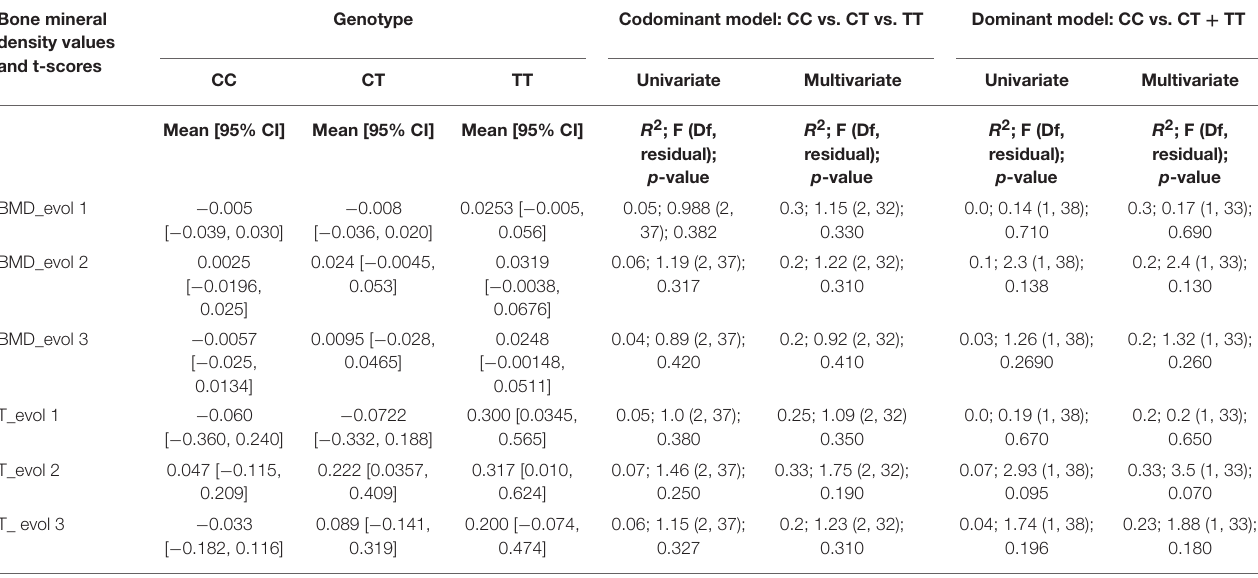
TABLE 3 | Association of ABCB1 polymorphism (rs1045642; CC vs. CT + TT) with bone mineralization changes at 1 year after kidney transplantation. Bone mineral density